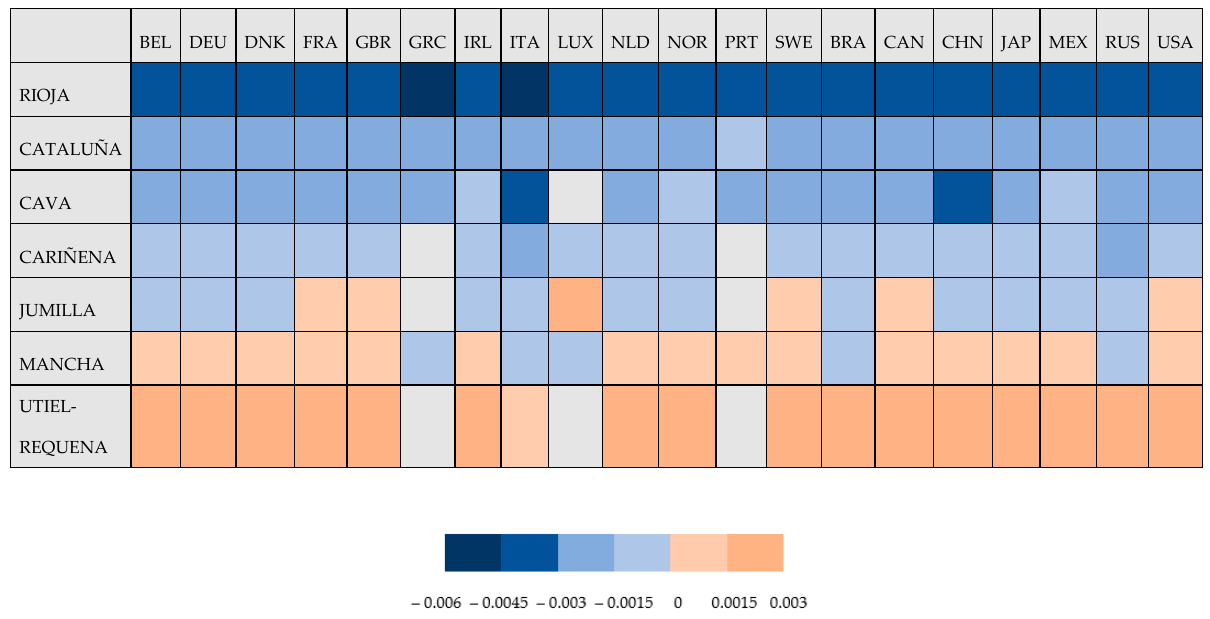
Figure 3. Variation in the CO 2 emissions per litre of exported wine by DO in the destination countries (2005–2016). The denominations of origin with the largest fall in emissions per litre of exported wine were Rioja, Cataluña and Cava, with Rioja being the DO for which the decline was